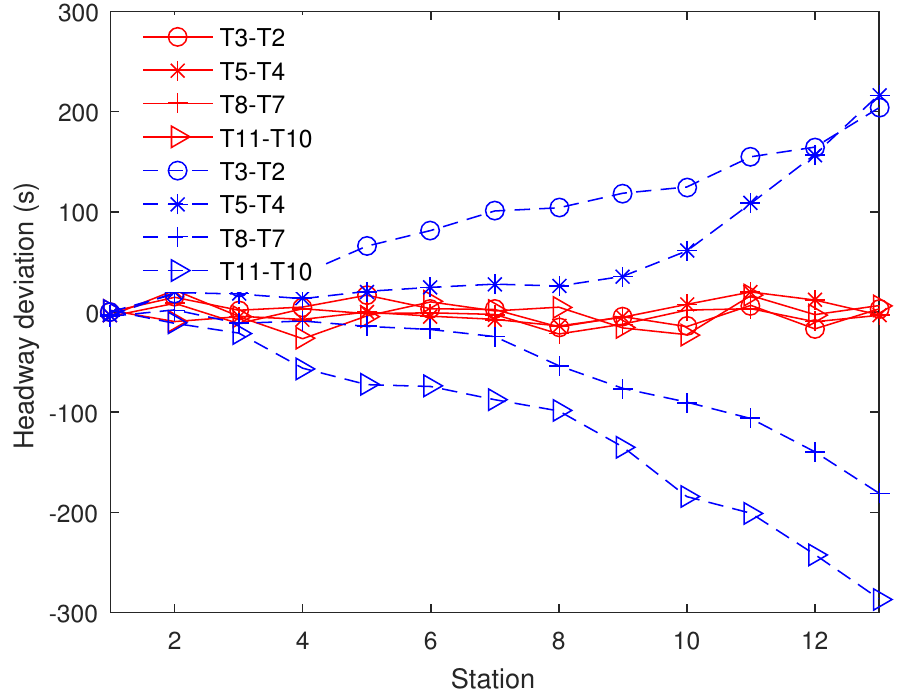
Figure 8. The headway deviation comparison between Case 1 and Case 2 (dashed blue lines correspond to Case 1, and solid red lines correspond to Case